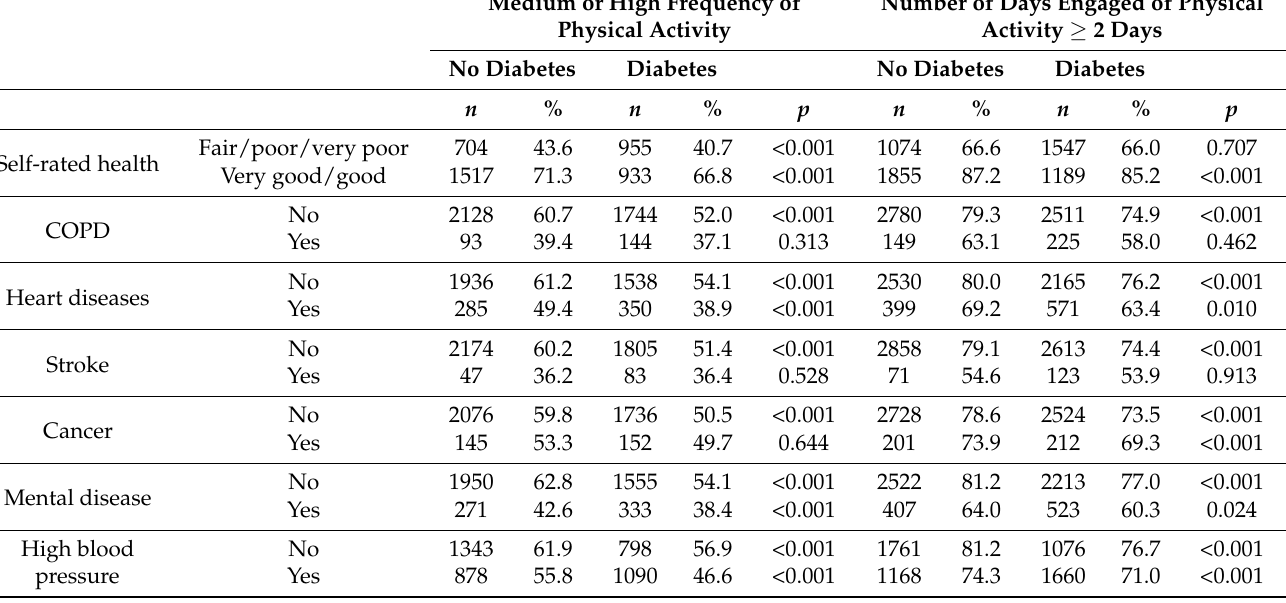
Table 3. Medium or high frequency of physical activity and number of days of physical activity ≥ 2 days among subjects with diabetes and gender–age-matched subjects without dia- betes participants of the European Health Interview Surveys for Spain (EHISS) conducted in years 2014 and 2020 according to clinical variables and